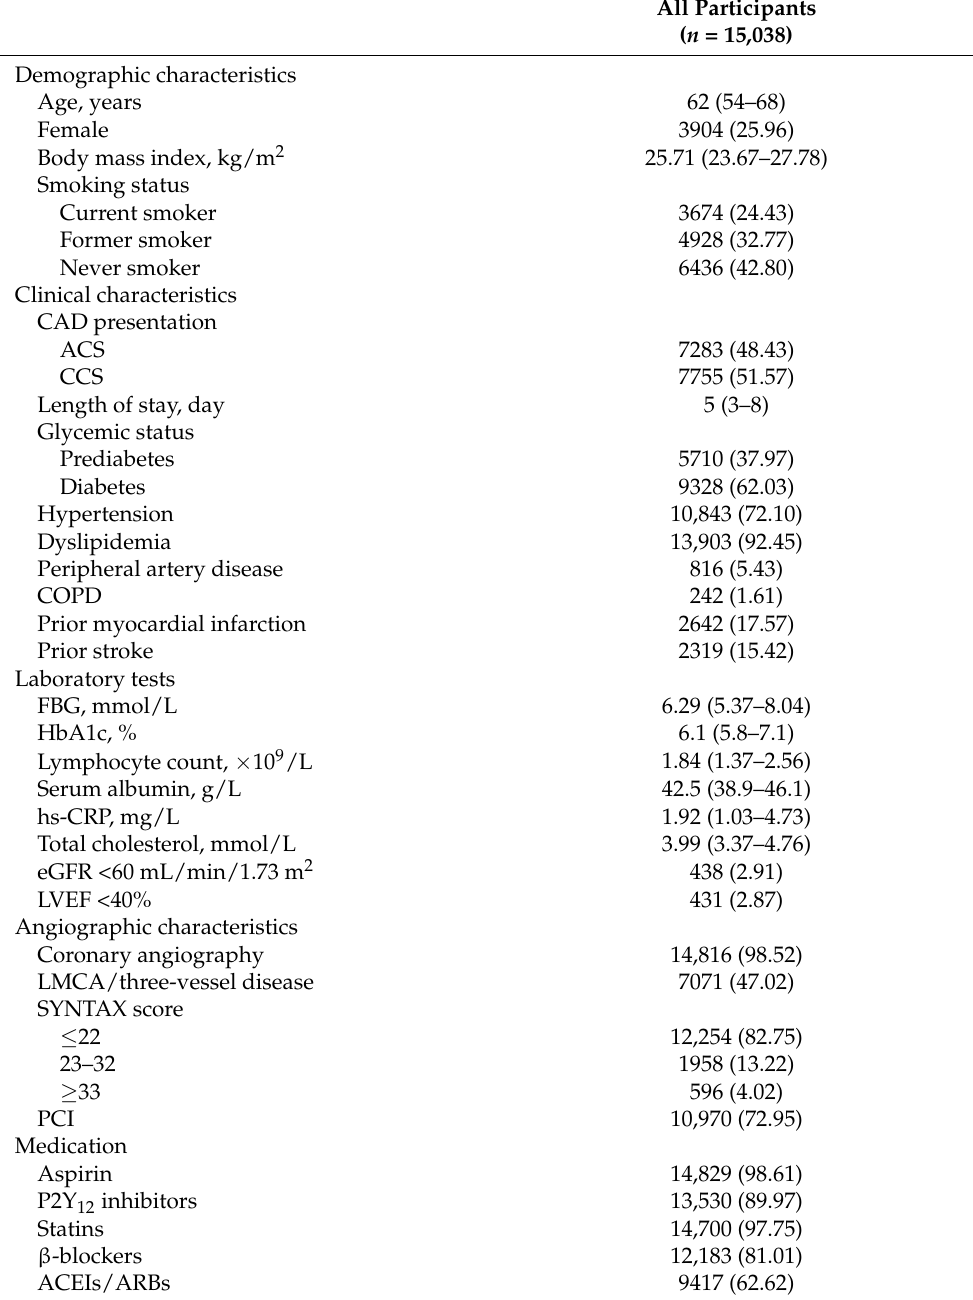
Table 1. Baseline characteristics of all